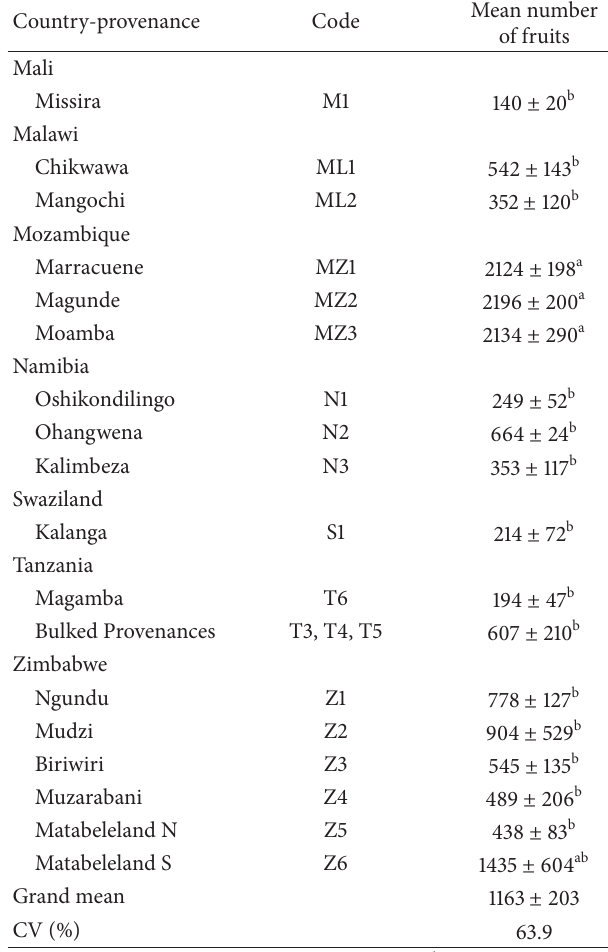
Table 2: Mean number of fruits per tree for fruiting trees per